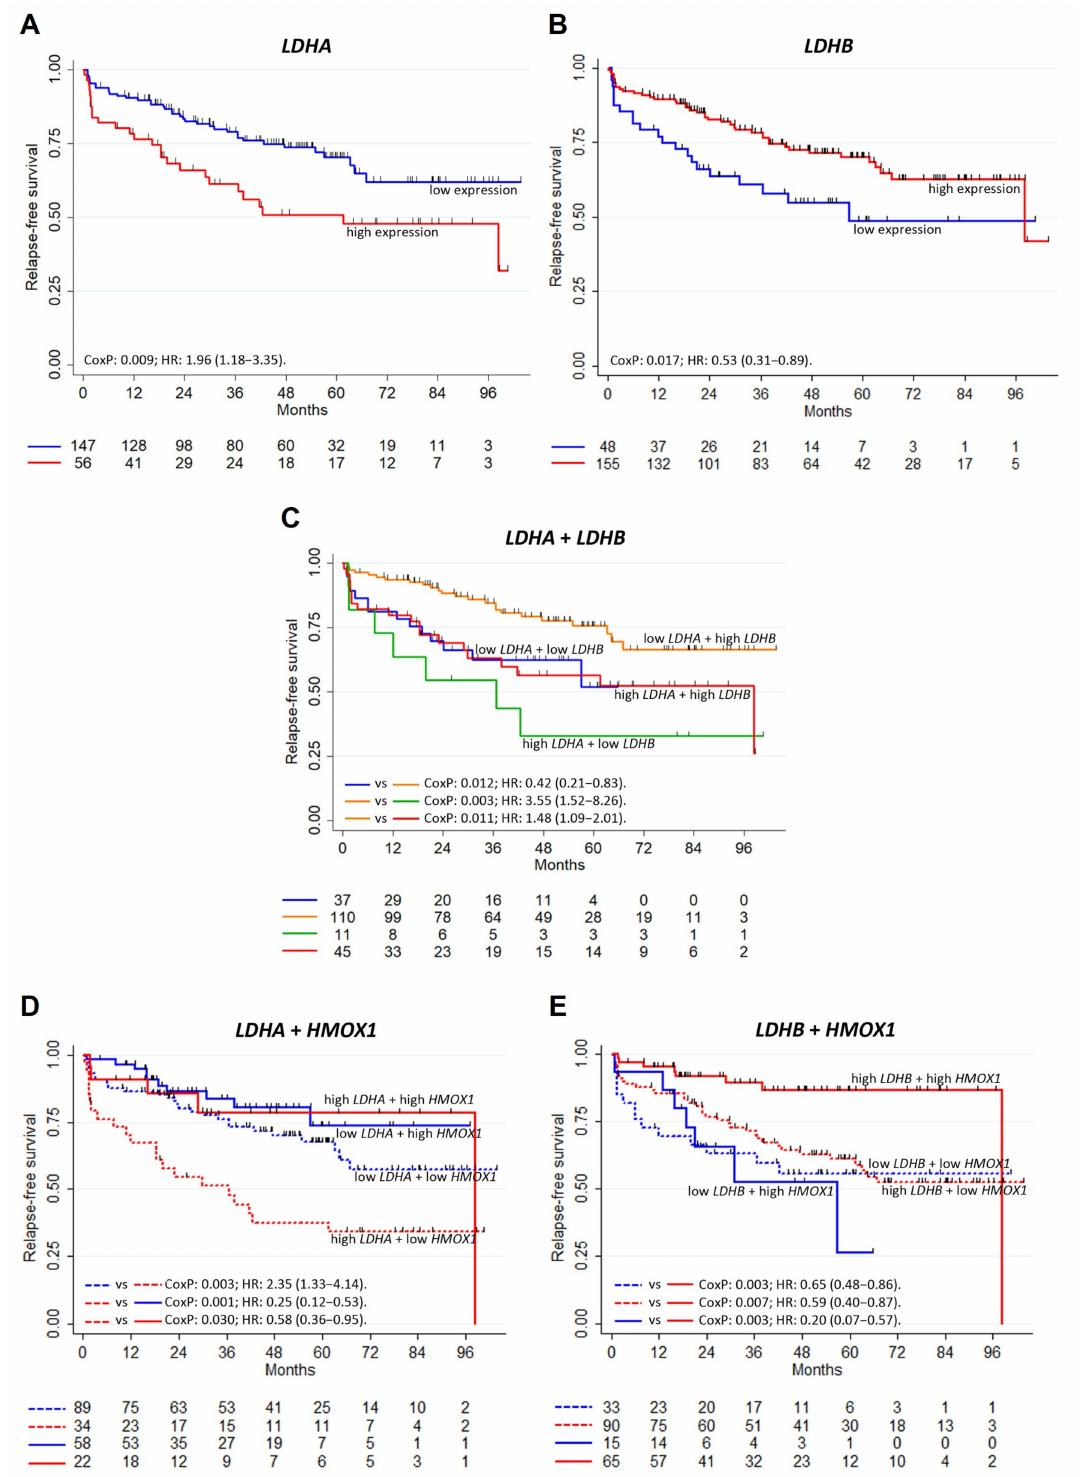
Figure 6. Analysis of LDHA , LDHB and HMOX1 as risk predictors of clinical outcome in PCa. Relapse-free survival (RFS) for PCa patients from Ross–Adams dataset (GSE70770) 39 ( n = 203). Kaplan–Meier curves for RFS of PCa patients with low and high expression levels of ( A ) LDHA and ( B ) LDHB, individually; ( C ) LDHA and LDHB , ( D ) LDHA and HMOX1 and ( E ) LDHB and HMOX1 combined. Cox P and HR: hazard ratio (95% confidence interval) are specified. Vertical marks show censored patients. Statistical significance was set at p <